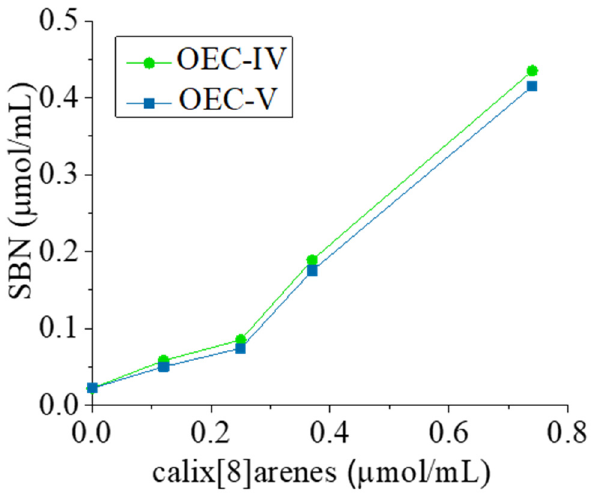
Figure 5. Phase solubility profiles of silibinin (SBN) in aqueous media containing various concentrations of OEC-IV (- ● ) or OEC-V (- ■ -) at 25 °C.